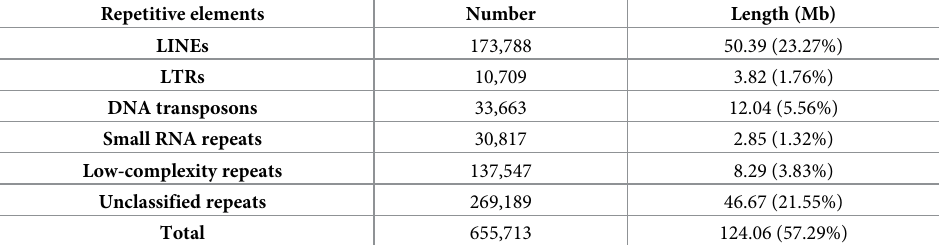
Table 2. Repetitive elements classified by repeat modeler and masked prior to the annotation of the Cardicola for- steri